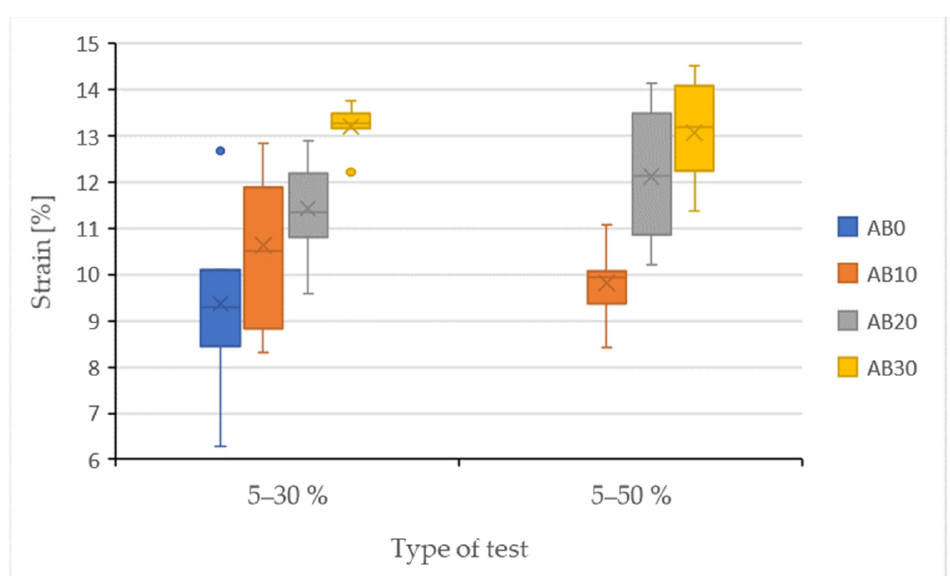
Figure 7. Results of the quasi-static test of adhesive bonds—strain.